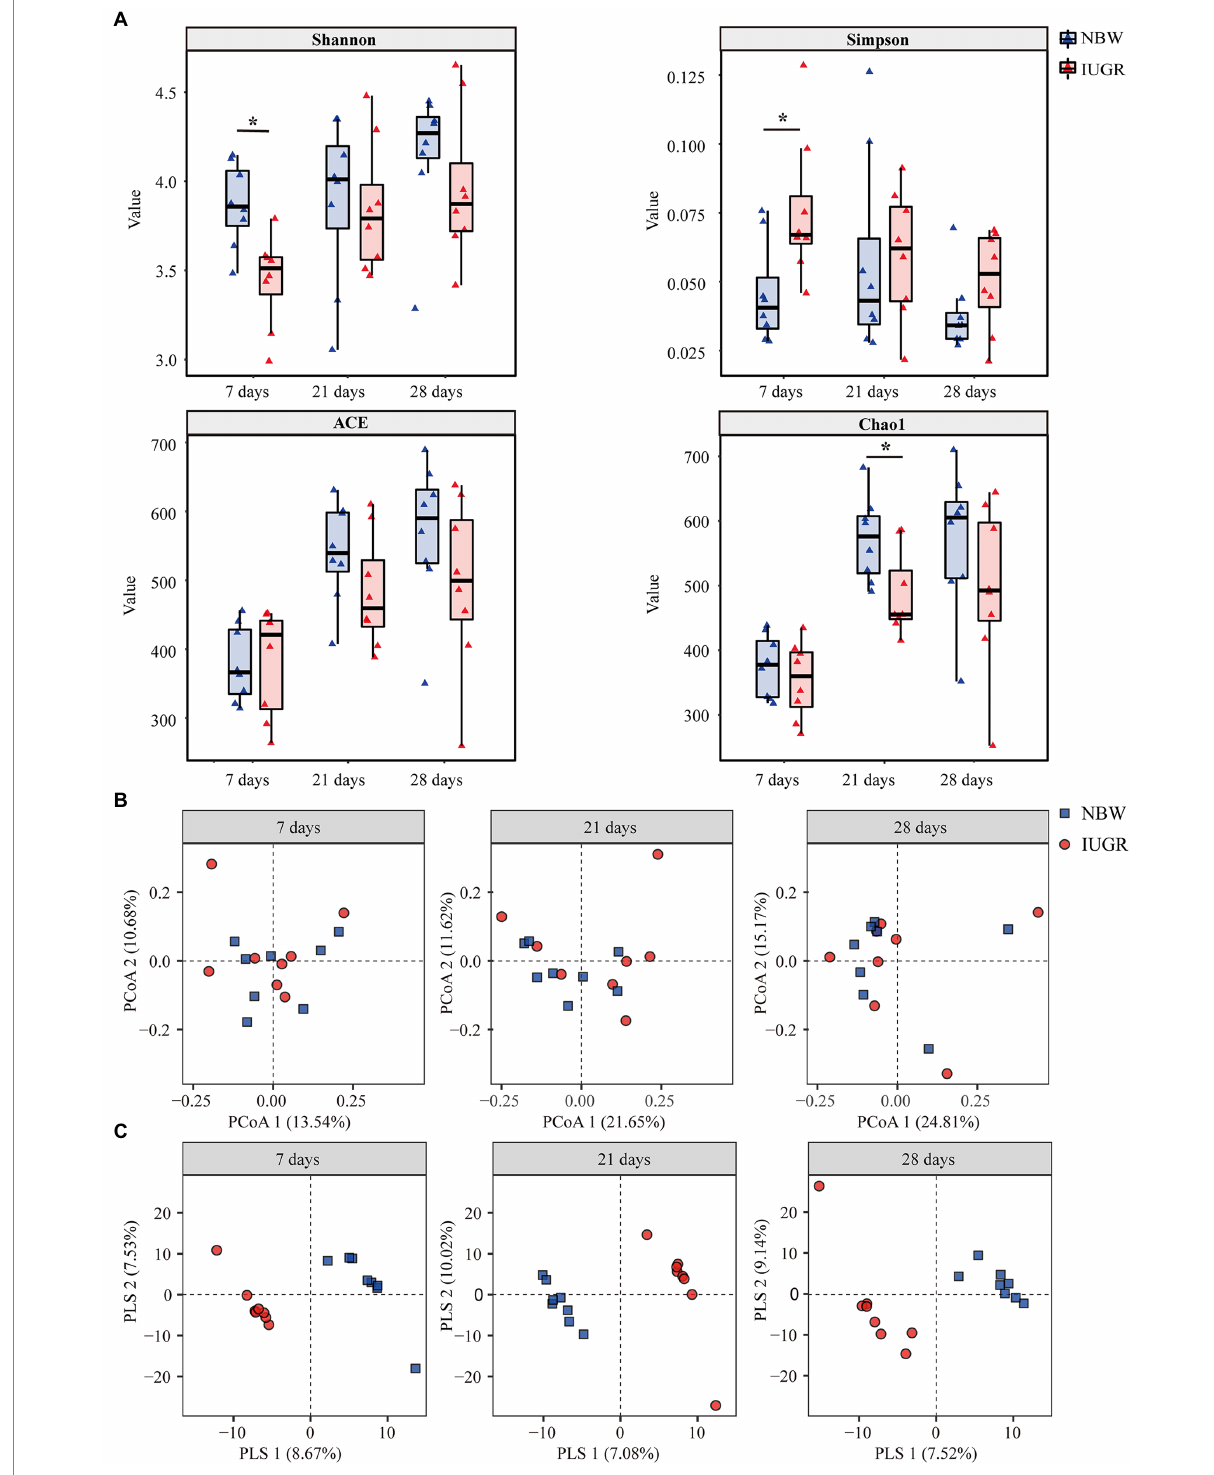
FIGURE 2 Differences in colonic microbial community diversity between the intrauterine growth restriction (IUGR) and normal birth weight (NBW) piglets at 7, 21, and 28 days of age. (A) The microbial Alpha diversity was measured using the Shannon, Simpson, ACE, and Chao indexes ( n = 8). (B) Principal coordinate analysis (PCoA) on unweighted UniFrac distances ( n = 8). (C) Partial least square discriminant analysis (PLS-DA) score plots of colonic microbiota ( n = 8). The IUGR group and NBW group are shown along the first two PCoA/PLS axes. Each symbol represents the gut microbiota of a piglet, red represents the IUGR group, and blue represents the NBW group. * p <